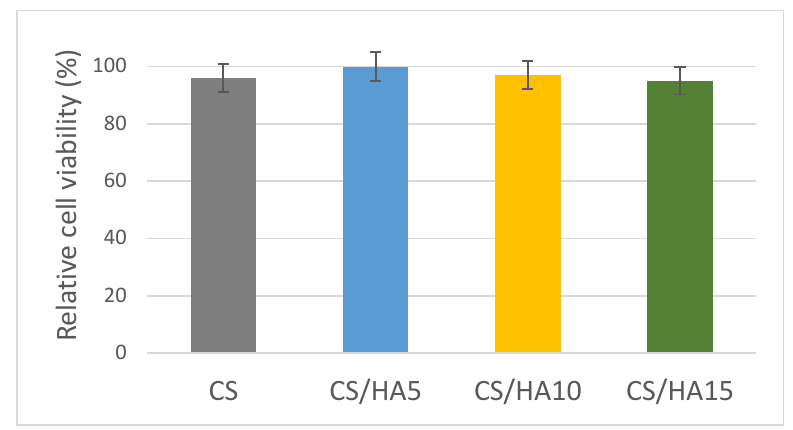
Figure 8. Fibroblasts viability on pure CS and CS / HA matrices over a 7-day period. Fibroblasts’ adhesion and proliferation was evaluated with immunofluorescence tests and microscopic observations (Figure 9).